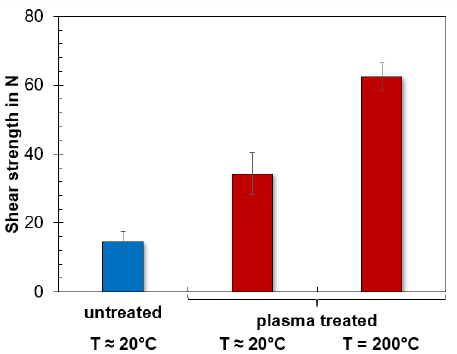
Figure 7. Shear strength of bond surfaces; pure fused silica and fused silica coated with a polarising beam splitter (PBS) coating, without any plasma treatment and after plasma treatment for 30 s and curing at different annealing